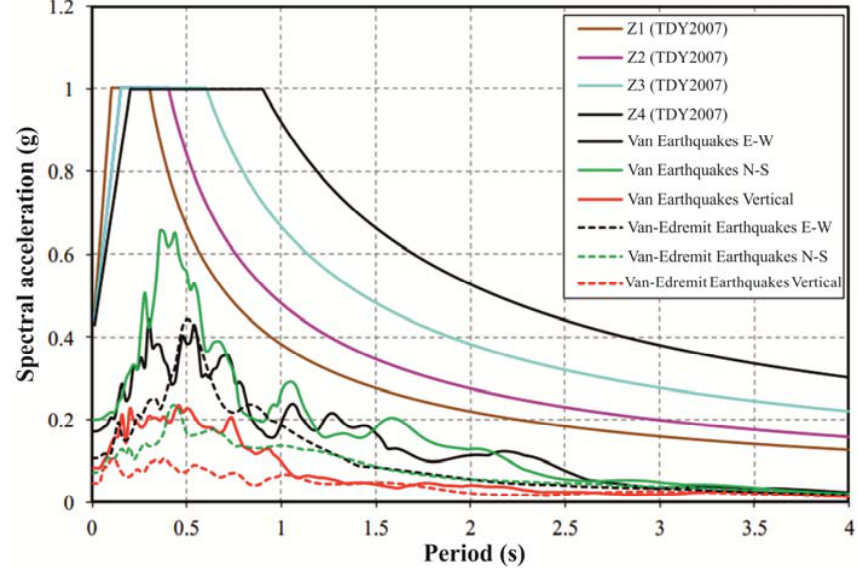
Fig. 4. Comparison of response spectra of Van-Erci ş Muradiye and Van-Edremit earthquakes with design spectra (Önen et al., 2011).